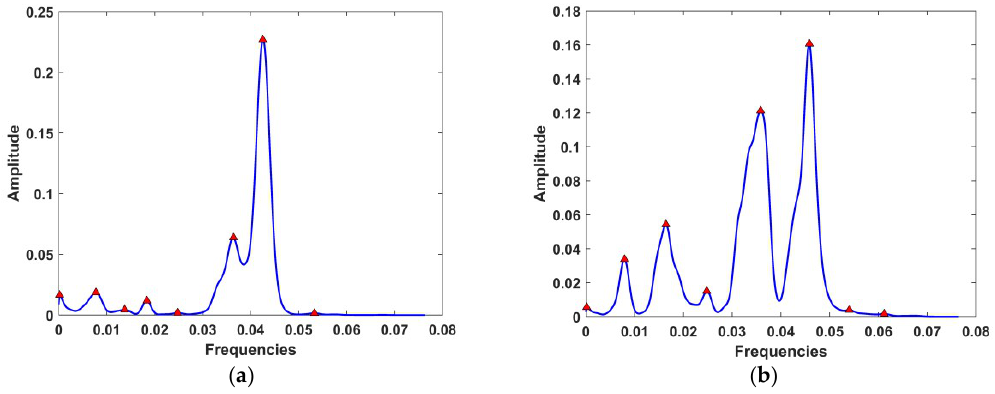
Figure 3. Spectral density of ( a ) ball faulty bearing ( b ) inner ring faulty bearing.